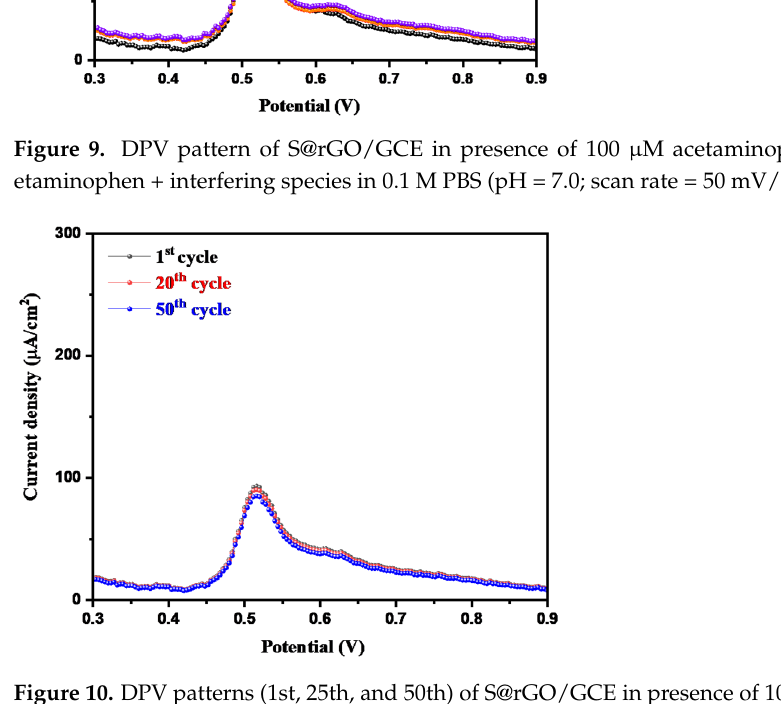
Figure 10. DPV patterns (1st, 25th, and 50th) of S@rGO/GCE in presence of 100 µM acetaminophen in 0.1 M PBS (pH = 7.0; scan rate = 50 mV/s).